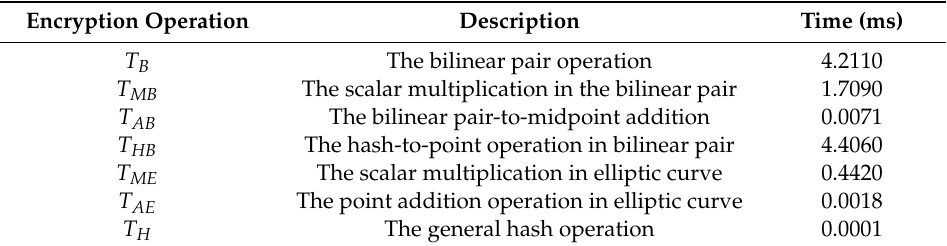
Table 4. Di ff erent encryption operation execution time.